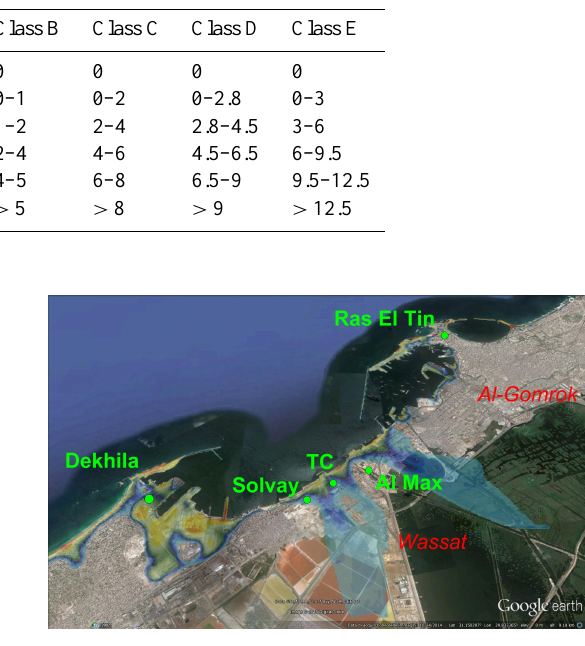
Figure 18. Zoom of the inundation area between the port of Dekhila and the port of Alexandria (covered by grid 4) under the assump- tion of tsunamis attacking in mean-sea-level conditions. A couple of toponyms and places of relevant industrial installations are also shown: Solvay represents Alexandria Sodium Carbonate, TC repre- sents Titan